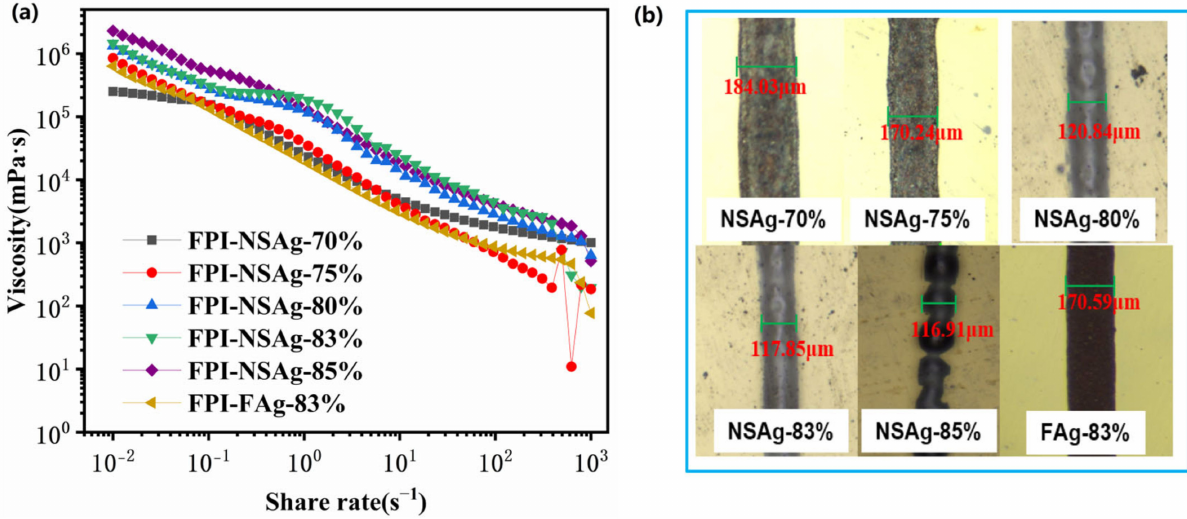
Figure 9. ( a ) The viscosities of nano silver pastes at continuously shear rates. ( b ) The optical micrograph of printed conductive